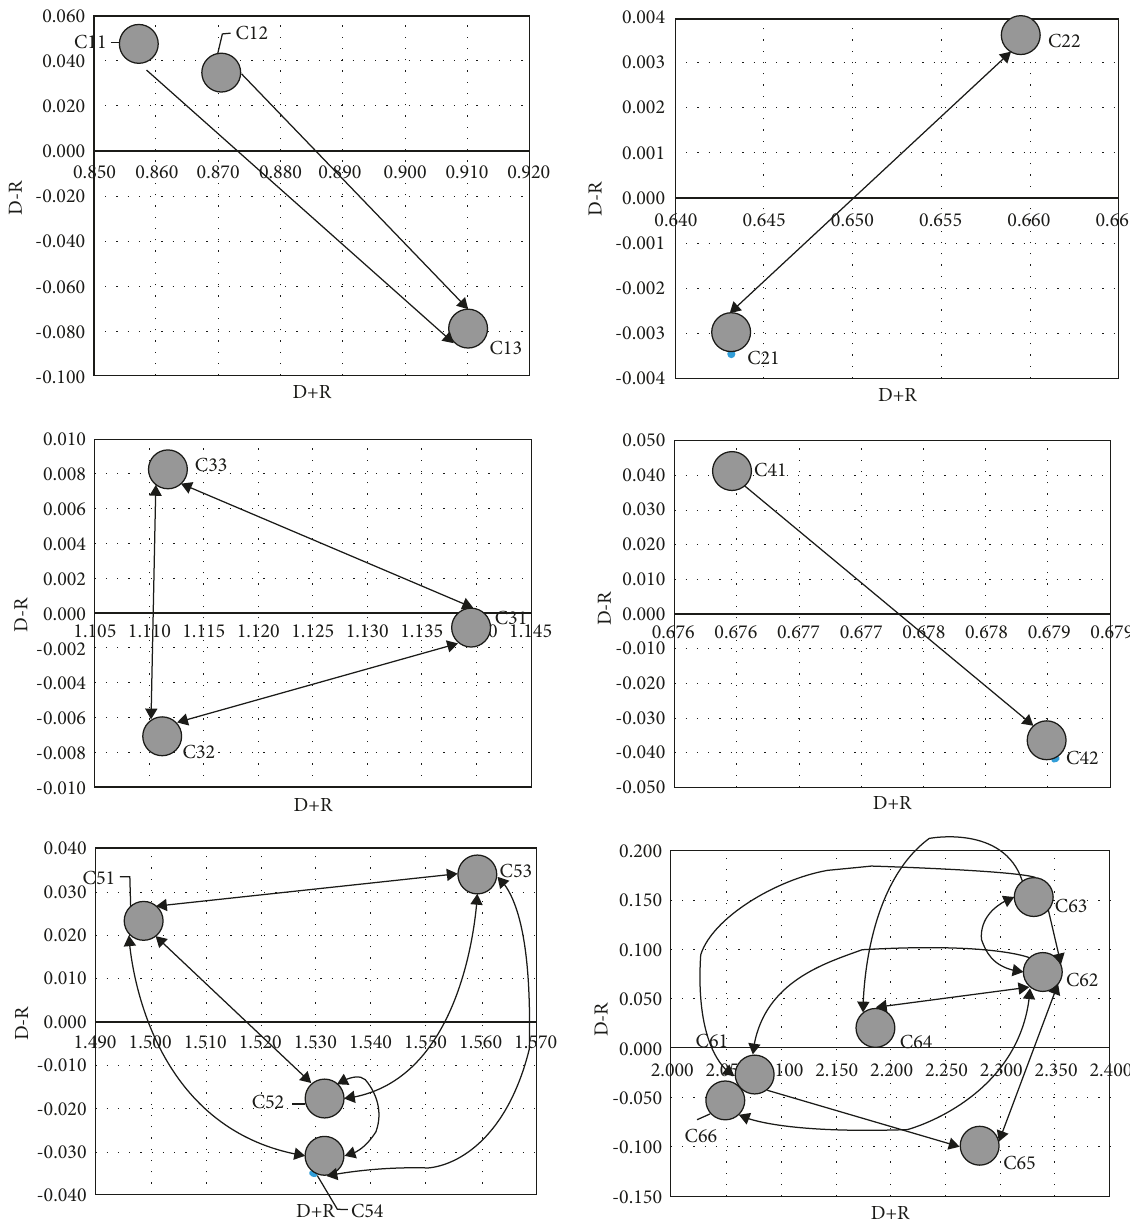
Figure 4: Causal diagram of